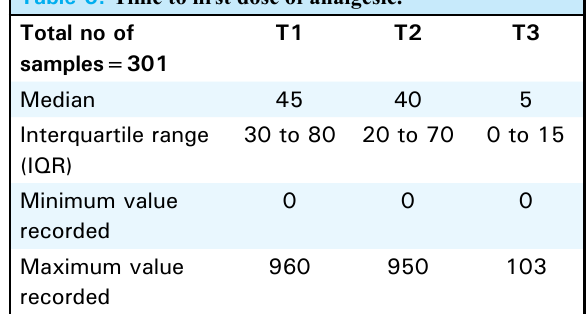
Table 6. Time to first dose of